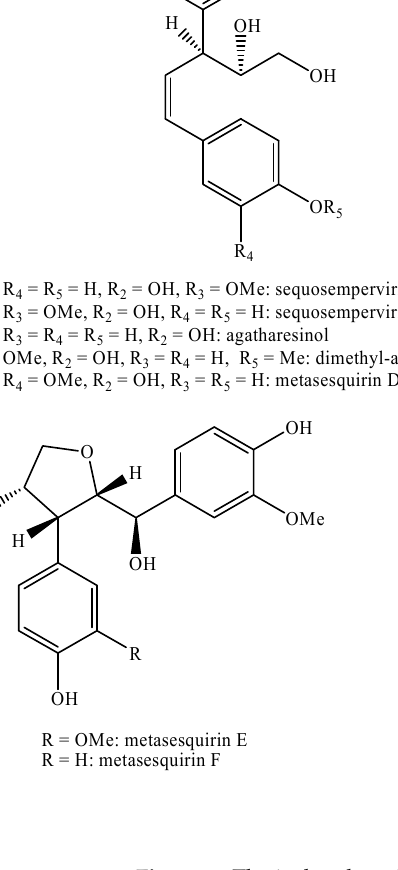
Figure 2. The isolated nor -lignans in the plant kingdom—part 1.